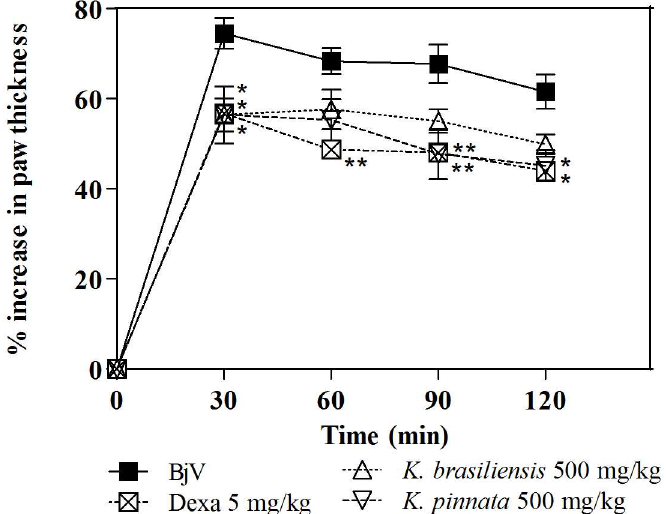
Fig 7. Inhibition of the edematogenic activity of B . jararaca venom (BjV) by extractsof K . brasiliensis (Kb) (A) and K . pinnata (Kp) (B) in post-treatment protocol. BjV was injected i.pl. in the right hind paw of mice 5 min before treatment with extract (500 mg/kg, i.p.). Paw thickness was measuredduring120 min after venom injection. Edema was expressedas the increasein paw thickness calculated, by the percentage difference betweenthe paw thickness after (at respective time) and before (basal values)venom injection. The points represent the mean ± SEM (n = 5). * p < 0.05and ** p < 0.01comparedto the group receivingvenom alone along with the i.p. injectionof 5% castor oil in PBS (Two-way ANOVA followedby the Bonferronitest).